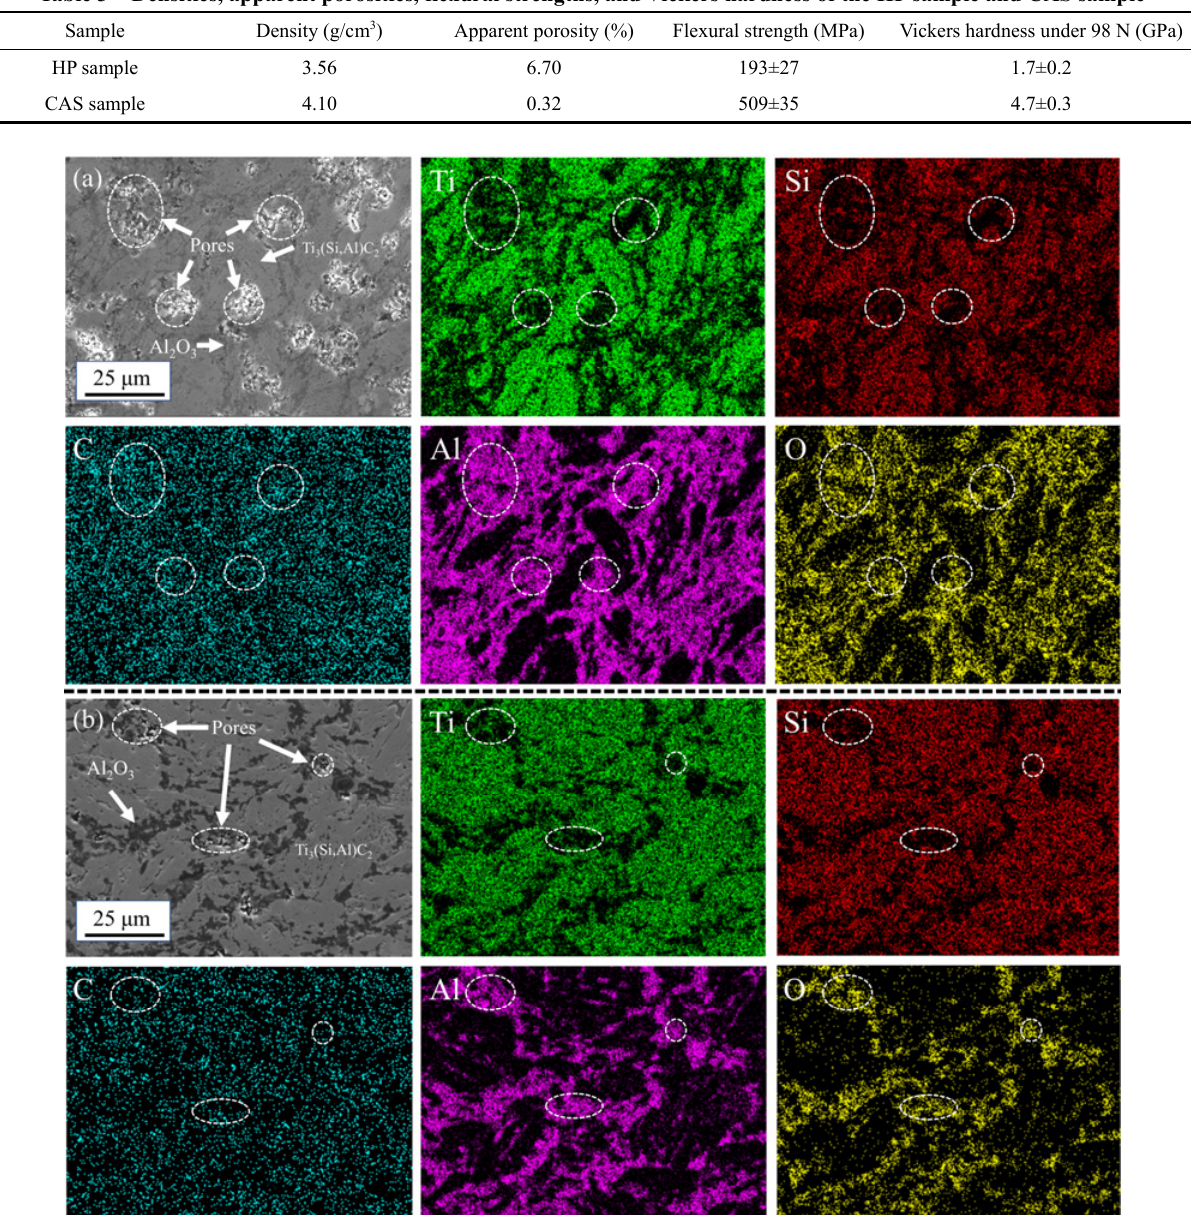
Table 3 Densities, apparent porosities, flexural strengths, and Vickers hardness of the HP sample and CAS sample